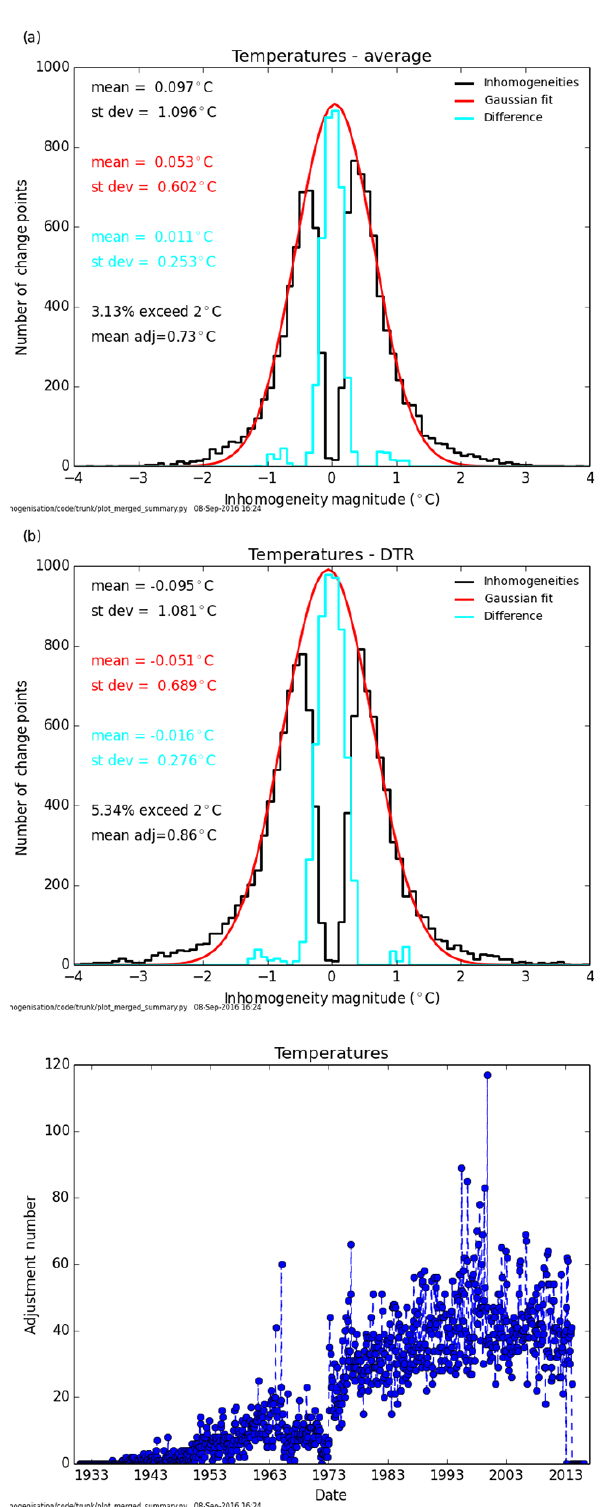
Figure 7. The distribution of inhomogeneities using the monthly mean temperatures (top panel) and diurnal (middle panel) temper- ature range. The number of change points found in each year from both the calculation methods (bottom panel) (see Dunn et al., 2014 for full details).